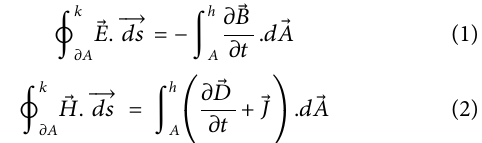
FIGURE 7 | EMF measuring dosimeter.